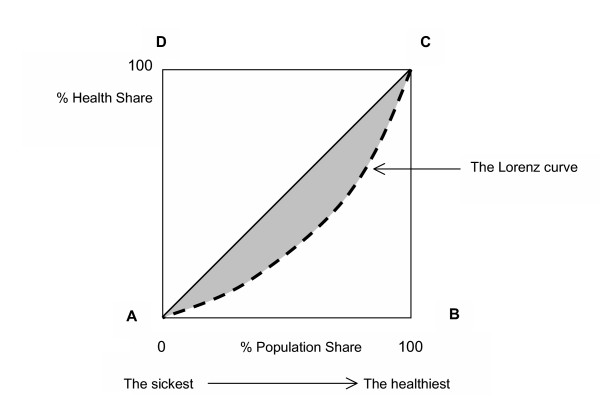
The Lorenz curve.